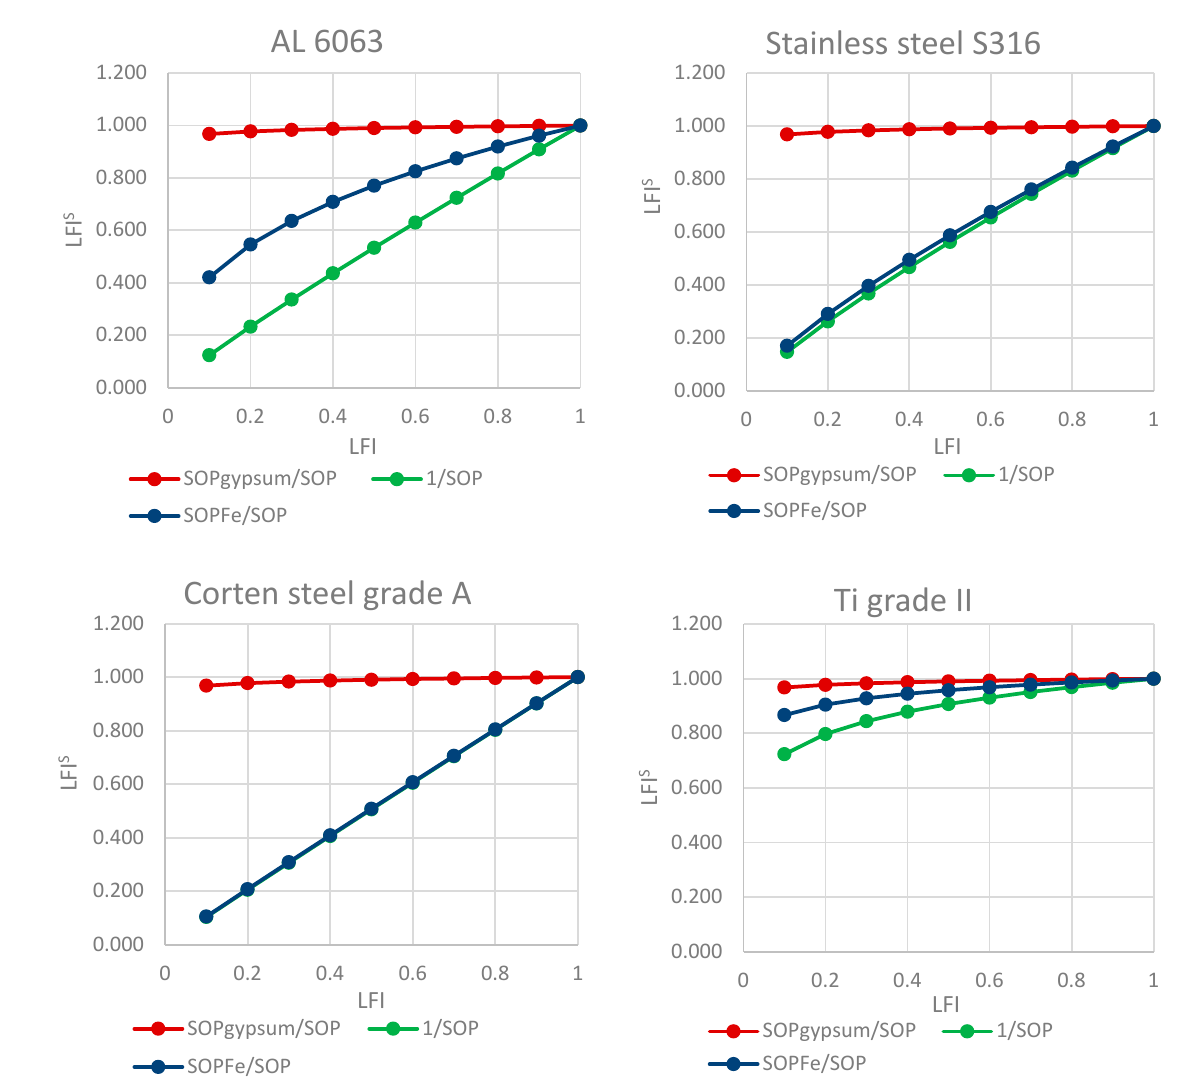
Figure 5. Visualisation of the impact of the different ways to calculate S from the SOP for the selected materials.